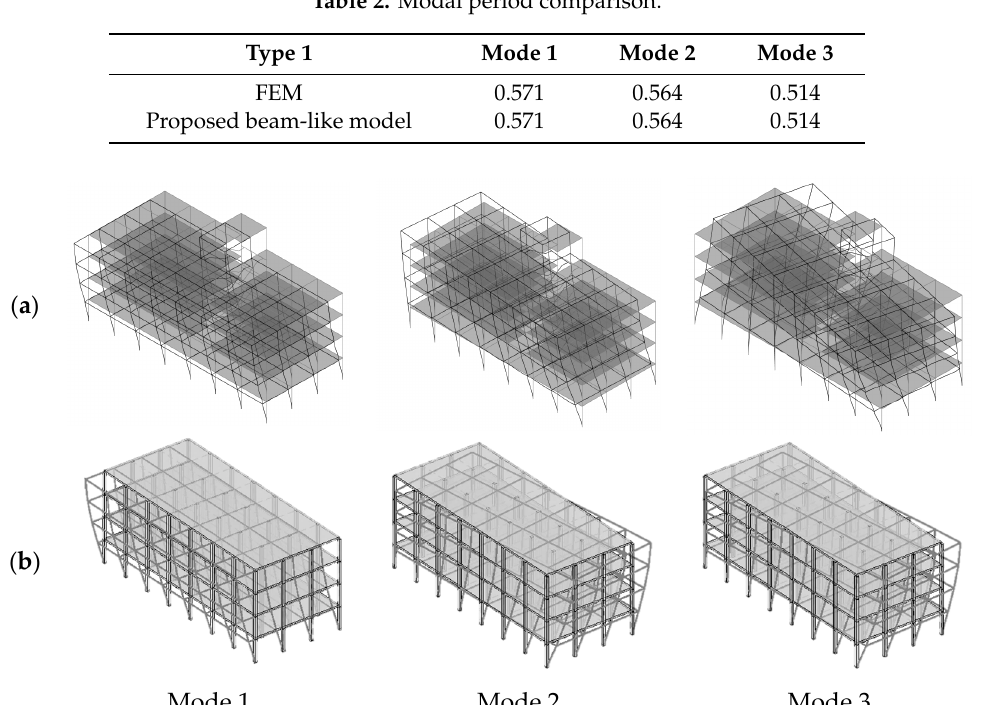
Figure 6. Four storey building benchmark (Type 1): ( a ) column cross section plan, and ( b ) the FEM model.